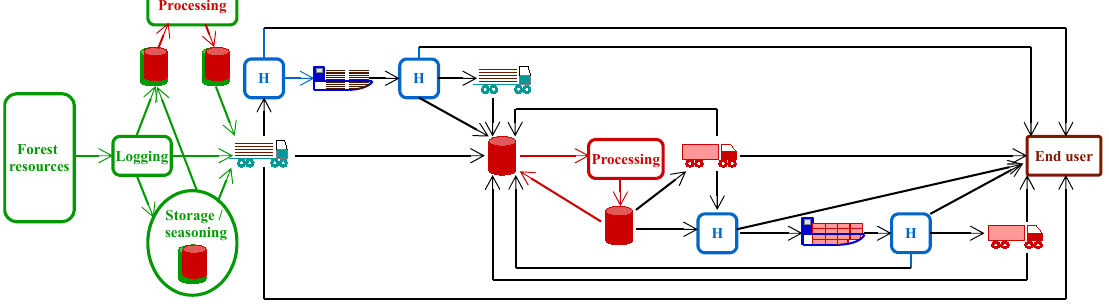
Figure 1. Value chain (VC) elements, transportation links and storage considered in the model (H: